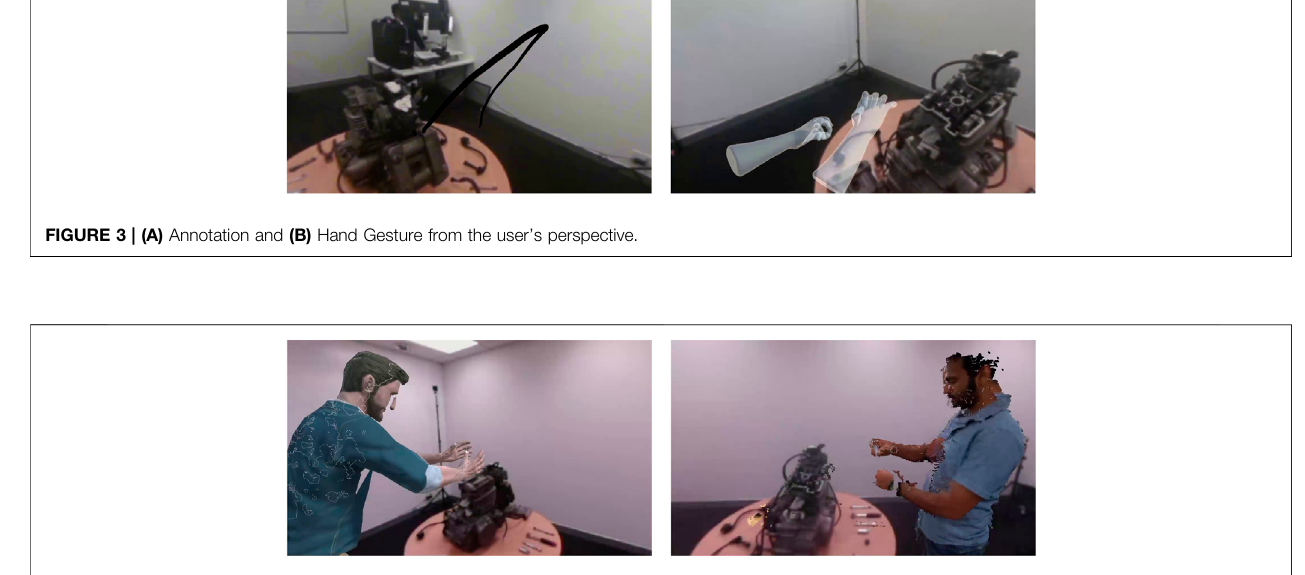
FIGURE 4 | (A) Avatar and (B) Volumetric visual cue from the user ’ s perspective.